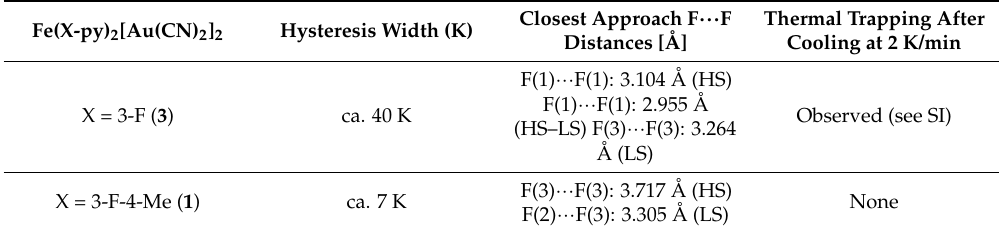
Table 2. Comparative hysteresis width, closest approach F ··· F distances, and presence or absence of thermal trapping for compounds 1 and 3 . SI = supplemental